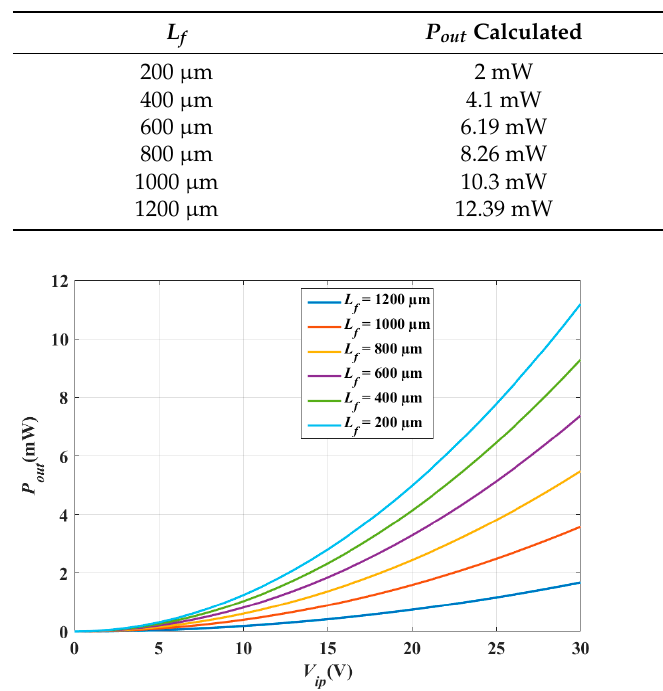
Figure 10. P out versus V ip at different W f .